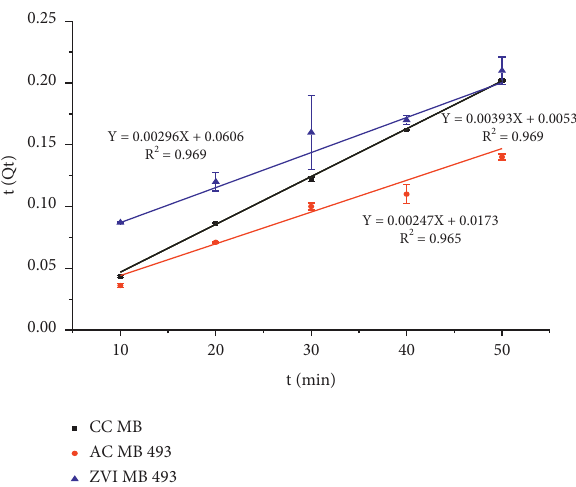
Figure 13: Adsorption curves of the pseudo-second-order model onto CC MB, AC MB 493, and ZVI MB 493 at 95 ° C. Table 4: Kinetics parameters of adsorption of β -carotene onto CC MB, AC MB 493, and ZVI MB 493. Pseudo-first-order Pseudo-second-order Intraparticle diffusion Adsorbents